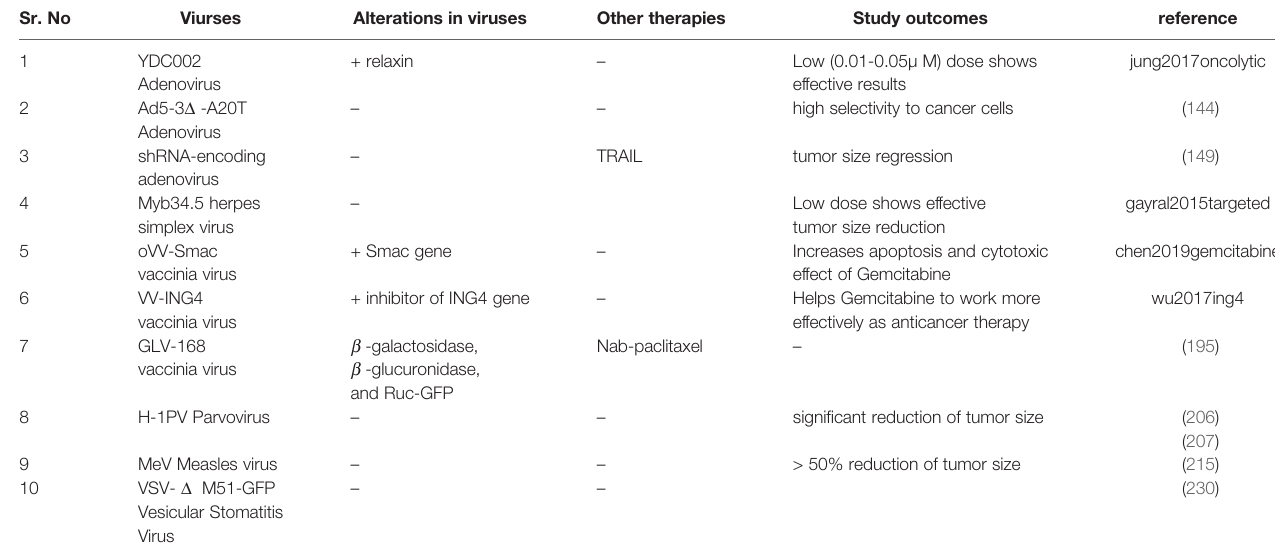
TABLE 3 | Preclinical studies related to combination therapy of Gemcitabine with recombinant or native oncolytic viruses. Sr. No